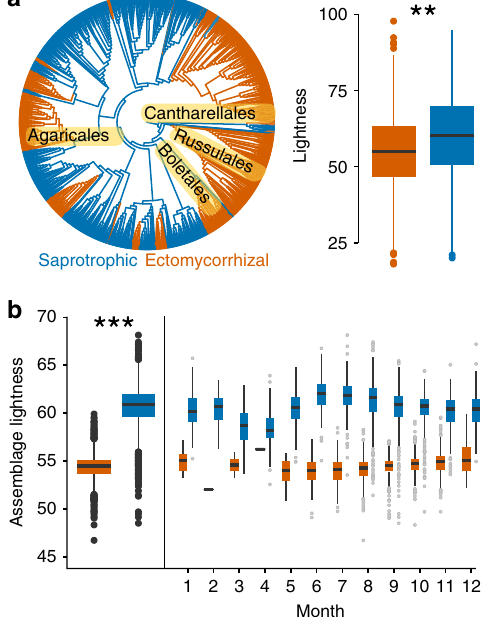
Fig. 3 Differences in mushroom color lightness between nutritional modes. a Phylogenetic distribution of saprotrophic (blue) and ectomycorrhizal fungal species (orange). Boxplot shows the lightness of the two nutritional modes of fungi (ectomycorrhizal and saprotrophic fungi) and the test results based on phylogenetic linear regression (model Lambda; z -value = 4.06; p -value < 0.001; Supplementary Table 2). b Difference in the assemblage-based average mushroom color lightness between saprotrophic and ectomycorrhizal fungi (for linear mixed effects model, Supplementary Table 3), and subdivided for each month of the year. Boxplots denote the median (horizontal line) and interquartile range (colored box); whiskers show three times the interquartile range; points indicate values outside this range. Source data underlying panel a are provided in Supplementary Data 1, 2, and 3 and source data underlying panel b are provided in Supplementary Data